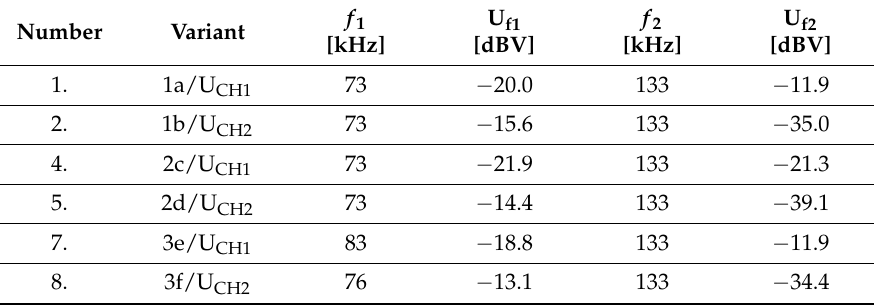
Table 1. List of the signal level measurements for the frequency f 2 = 133 kHz and for the highest disturbance components f 1